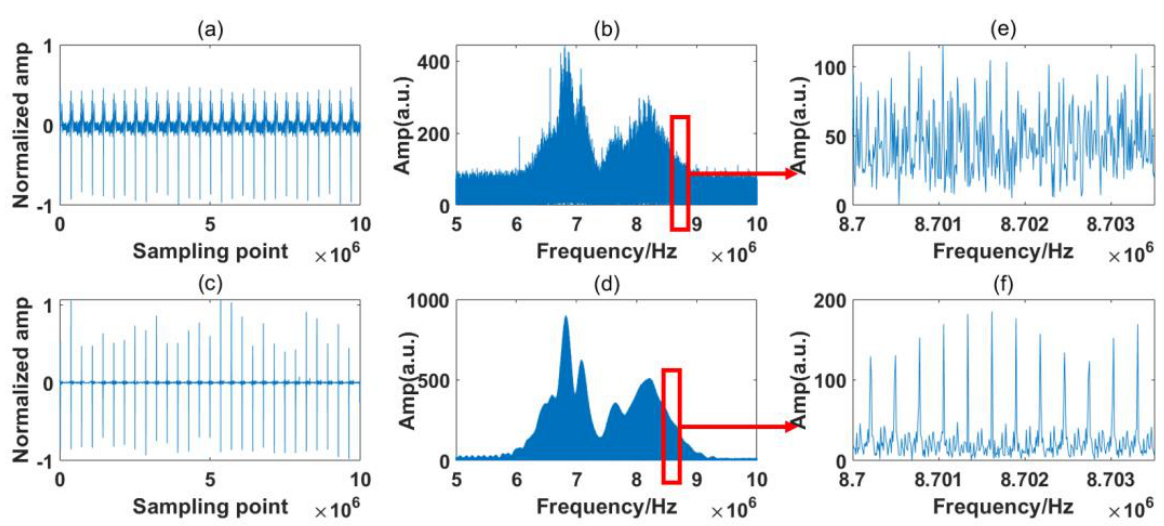
Figure 12. Experiment of the reference path signal. ( a ) Raw time domain signal; ( b ) raw frequency domain signal; ( c ) corrected time domain signal; ( d ) corrected frequency domain signal; ( e ) Magnified view of red rectangle shown in ( b ); ( f ) Magnified view of red rectangle shown in ( d ).